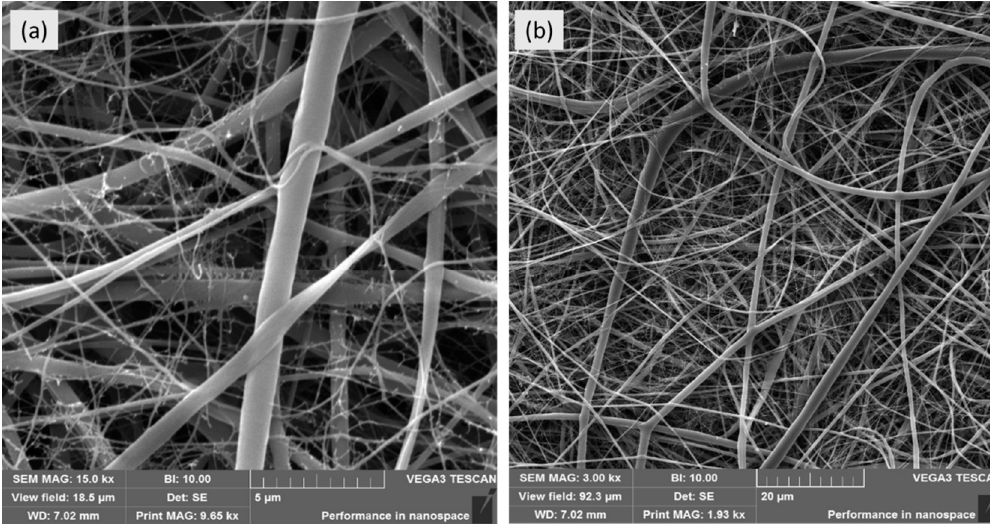
Figure 2. Images acquired with SEM microscope showing nanofiber structure. Panel ( a ) show nanofiber at 15 k magnification. Panel ( b ) show nanofiber at 3 k magnification.